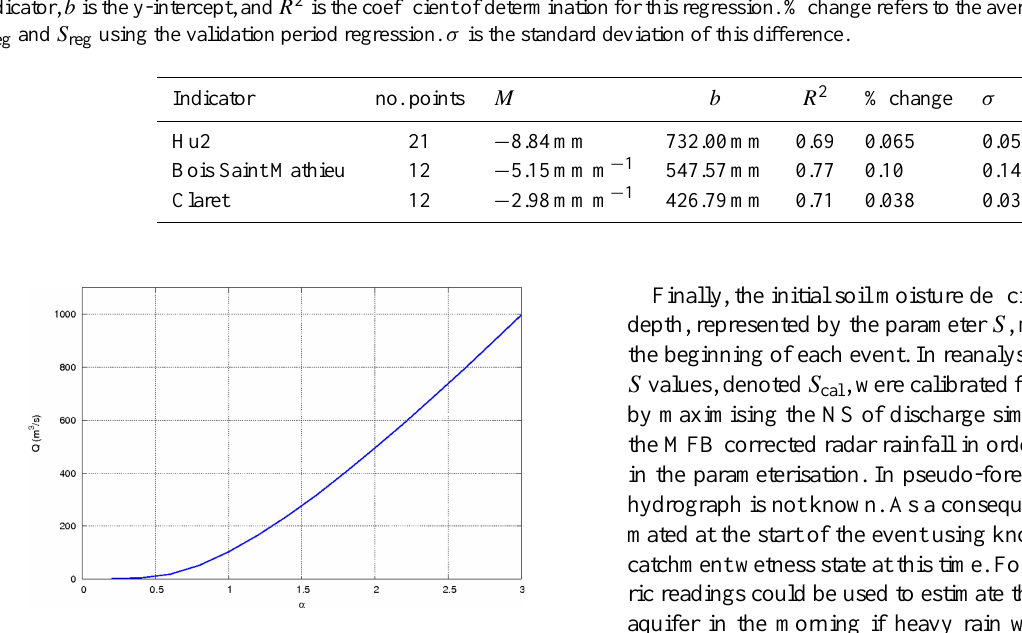
Fig. 3. Discharge as a function of α at 3h before the flood